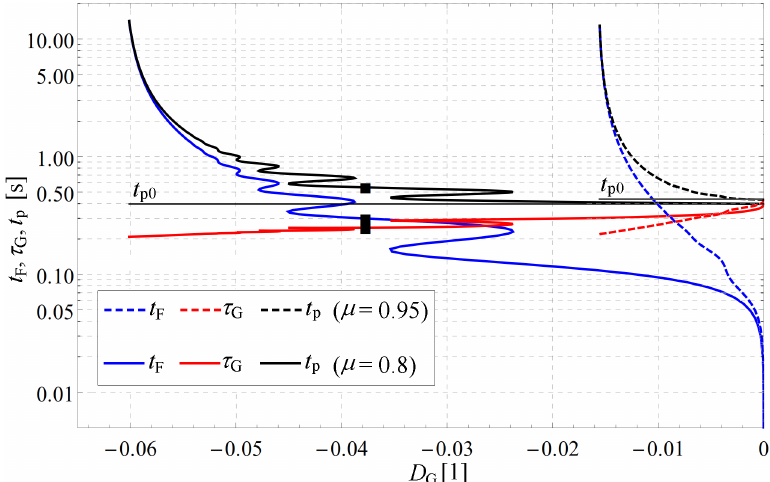
Figure 6. The flight phase time period, the ground phase time period and the entire time period.